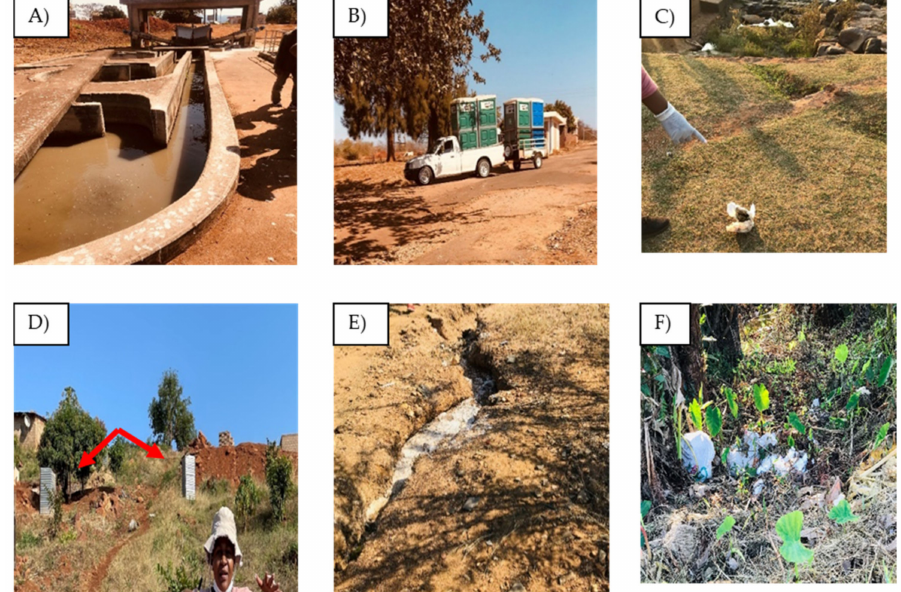
Figure 2. Photographs of sanitation facilities and WWTP observed around the study area: ( A ) Tswinga WWTP in Thulamela, ( B ) mobile toilets to be emptied at local WWTP, ( C ) diapers next to Luvuvhu River in Mhinga, ( D ) pit latrines in Tshivhulani households, ( E ) open defecation run offs next to a river in Mhinga, and ( F ) open defecation next to Nandoni